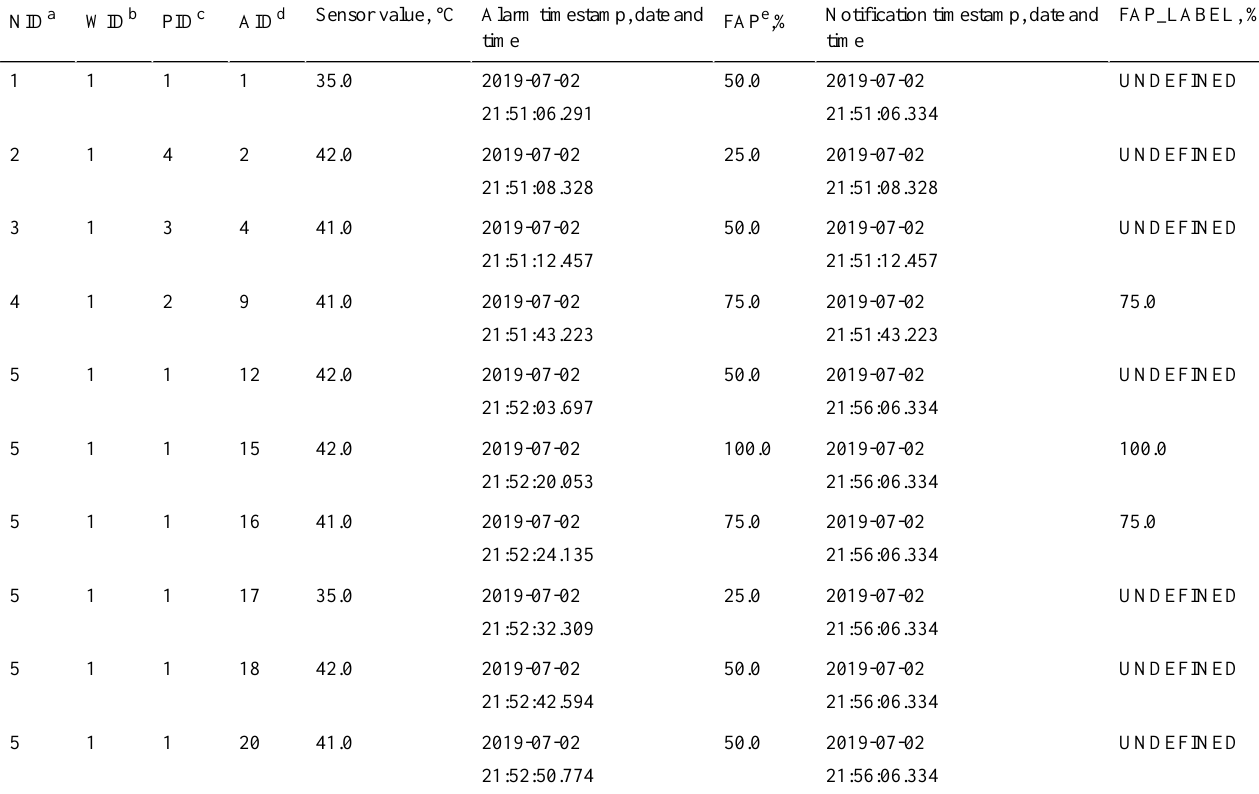
Table 4. Results of our experiments for notifications related to temperature